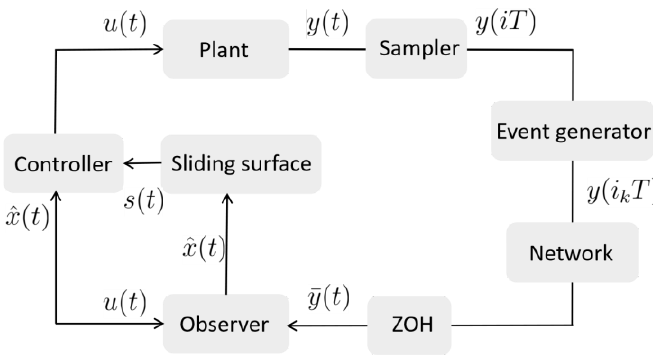
Figure 5. The diagram of overall closed-loop system.